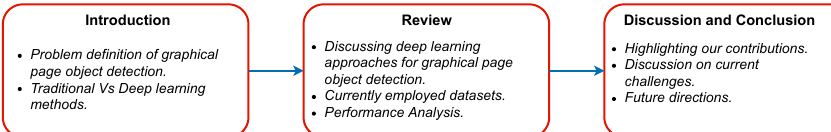
Figure 3. The block diagram illustrating the complete flow of the survey paper.